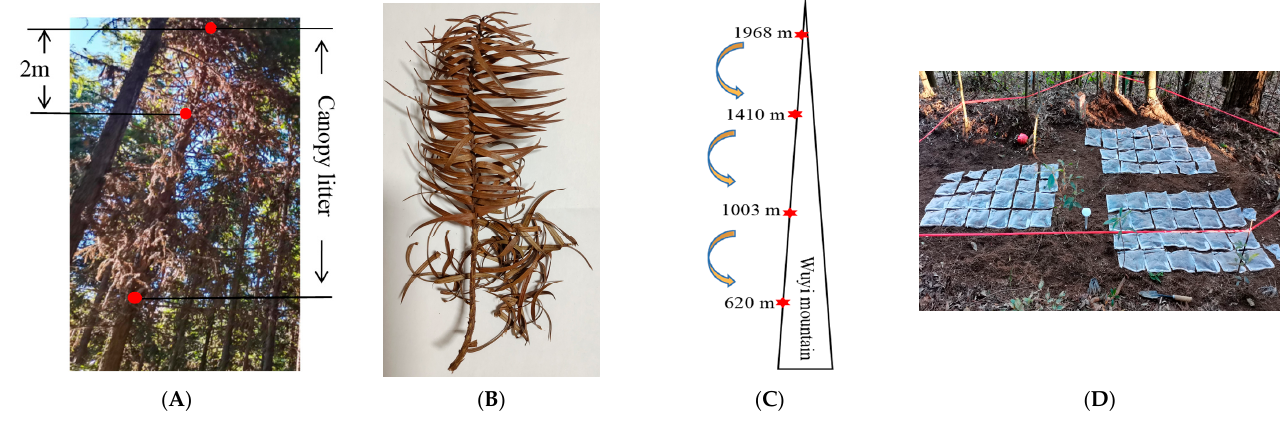
Figure 5. Material collection and experiment design. ( A ) Canopy litter collection range. ( B ) Rela- tively intact branches. ( C ) Locations of the decomposition sites. ( D ) Placement of decomposition bags.